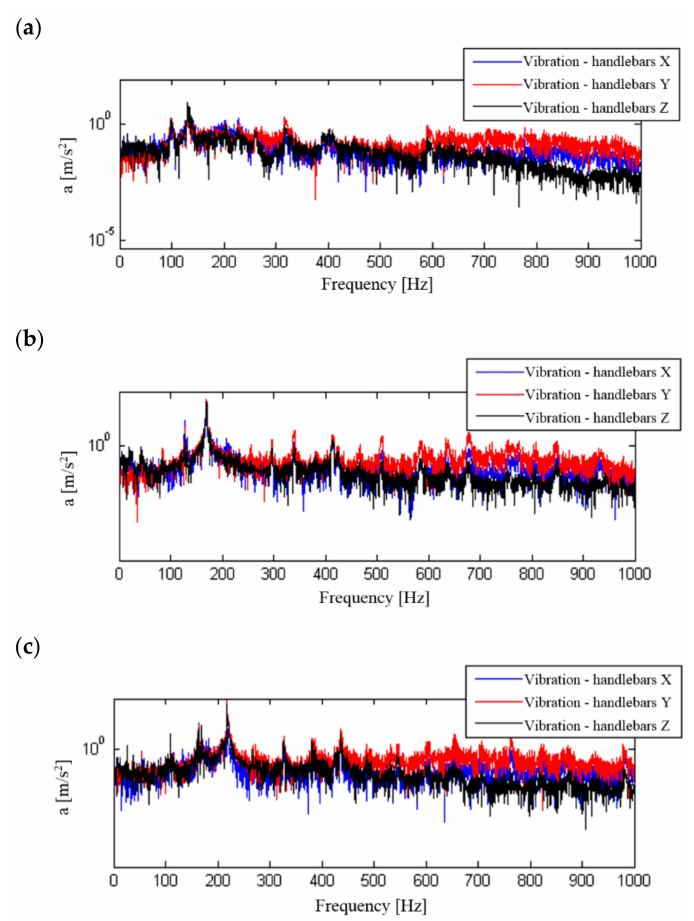
Figure 12. Frequency analysis of general vibration (handlebars) in the X, Y and Z directions: ( a )